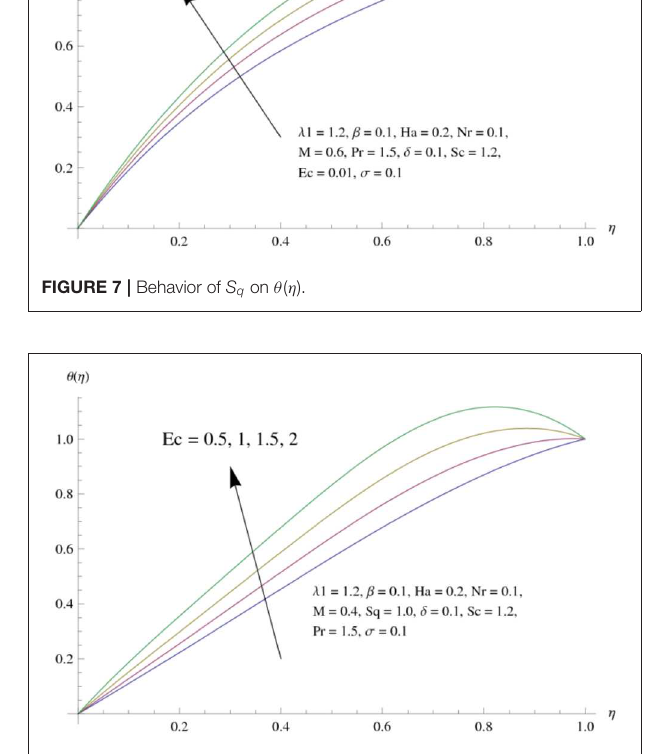
FIGURE 8 | Behavior of Ec on θ ( η ).